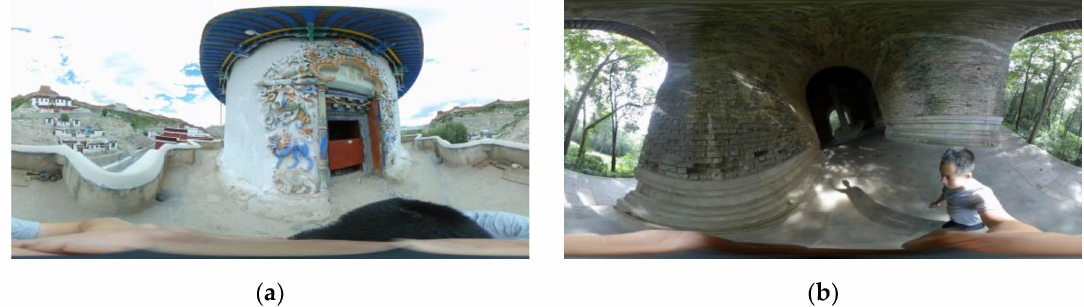
Figure 3. Examples of extracted video frames of the two datasets. ( a ) The Stupa; and ( b ) the